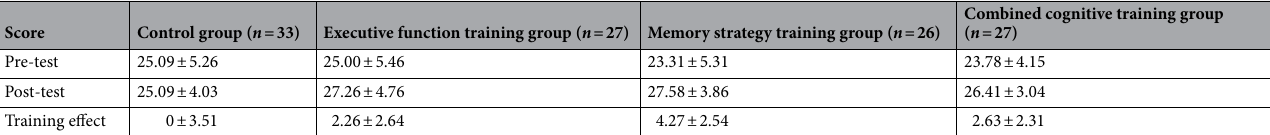
Table 3. Differences between prospective memory in the prospective and retrospective memory questionnaire-prospective memory (PRMQ-PM) scores before and after intervention (mean [ M ] ± standard deviation [ SD